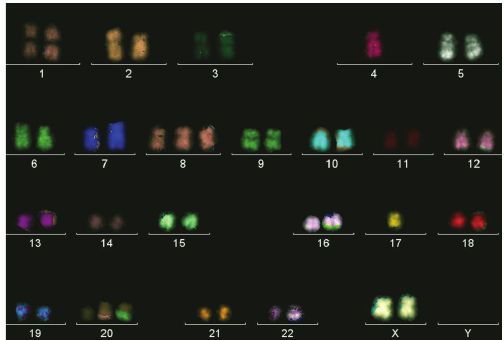
Figure 1: A representative metaphase from RKO cell line. Note that rearranged chromosomes described in Section 3 and not seen here were observed in two or more other